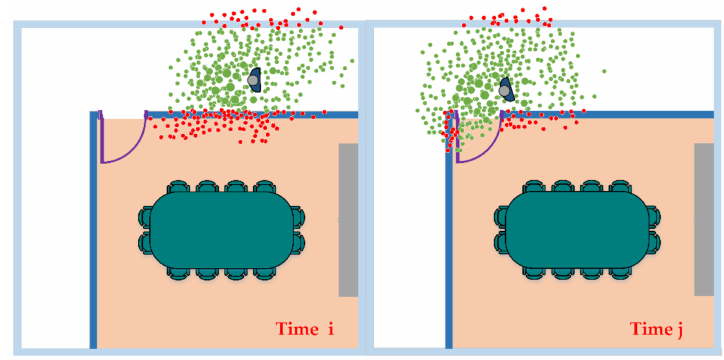
Figure 8. Schematic diagram of map